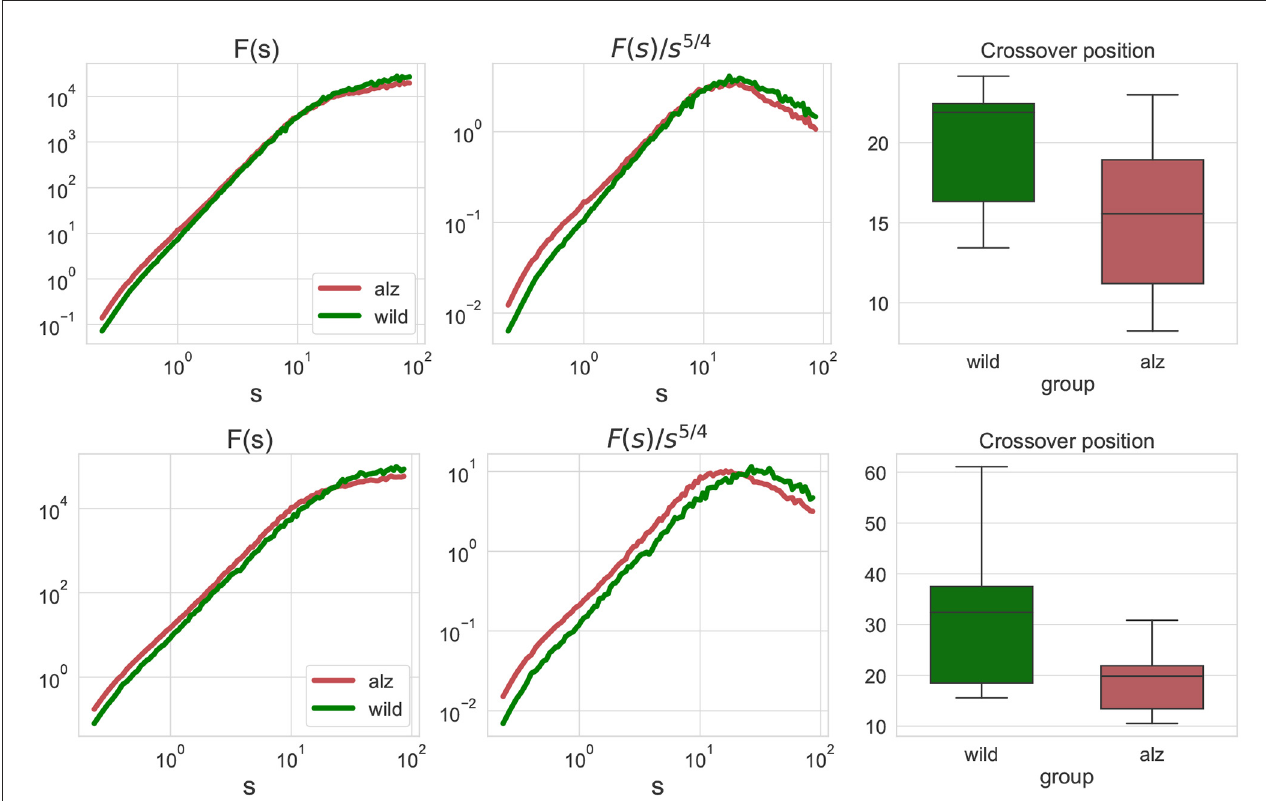
FIGURE3 Similar fluctuation functions F j ( s ) as Figure 2 but for all pairwise combinations of movement trajectories for different body parts j 1 (cid:54)= j 2 obtained by 1 , j 2 detrended cross-correlation analysis (DCCA). Scales and crossover positions are expressed in seconds.